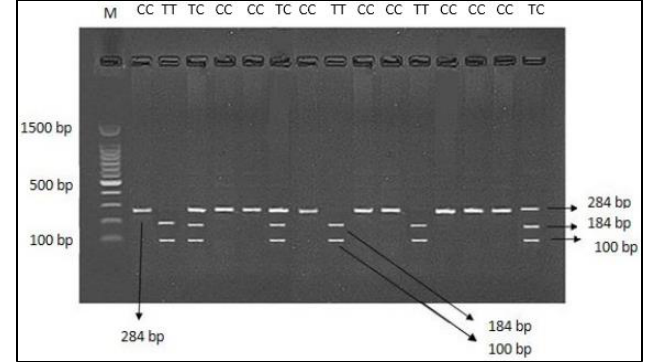
Figure 3. RsaI restriction fragment patterns of TGF- β2 by PCR -RFLP on 1.5% agarose gel. M= 100 bp ladder; TT, TC, CC =